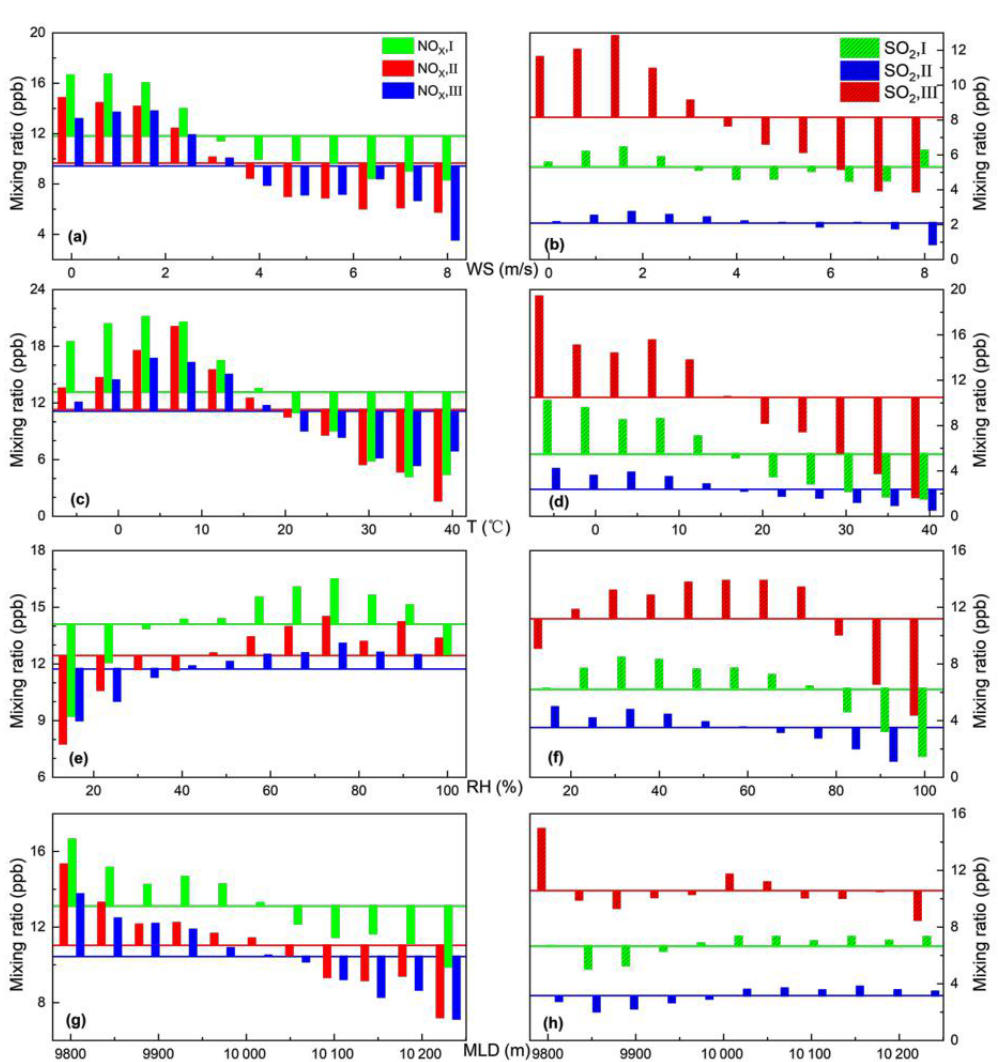
Figure 5. Variation characteristics of NO x and SO 2 with wind speed (WS; a and b ), temperature ( T ; c and d ), relative humidity (RH; e and f ) and the mixed-layer depth (MLD; g and h ) at LAN during period I (2006–2009), period II (2010–2013) and period III (2014–2016). The horizontal lines in the graph indicate the average values of NO x and SO 2 for each period. Columns indicate changes relative to the corresponding mean